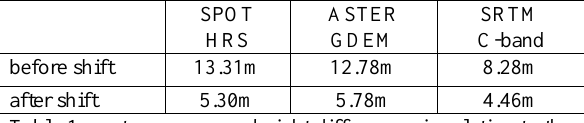
Table 1: root mean square height differences in relation to the